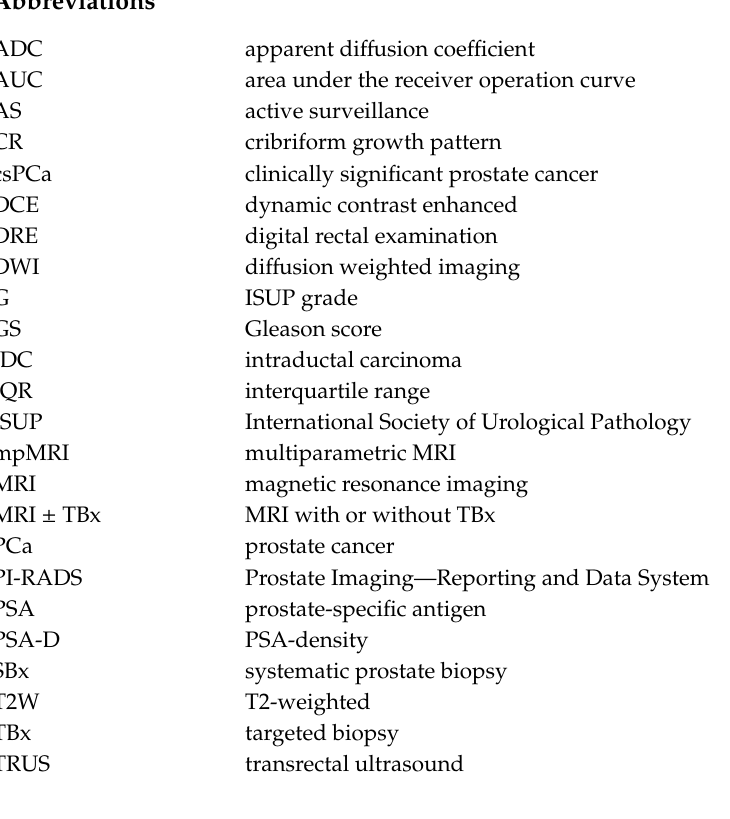
Table S1: Performed and avoided targeted biopsy sessions and numbers of prostate cancer diagnoses detected and missed in PI-RADS 3 patients with di ff erent thresholds for clinically significant prostate cancer, when using largest index lesion diameter only as stratification tool. TBx: targeted biopsy; ISUP: International Society of Urological Pathology; PCa: prostate cancer; CR: cribriform growth pattern; IDC: intraductal carcinoma. Table S2: Performed and avoided targeted biopsies procedures and numbers of prostate cancer diagnoses detected and missed in PI-RADS 3 lesions with di ff erent thresholds for clinically significant prostate cancer, when using largest lesion diameter as stratification tool. TBx: targeted biopsy; ISUP: International Society of Urological Pathology; PCa: prostate cancer; CR: cribriform growth pattern; IDC: intraductal carcinoma. Table S3: Specifications